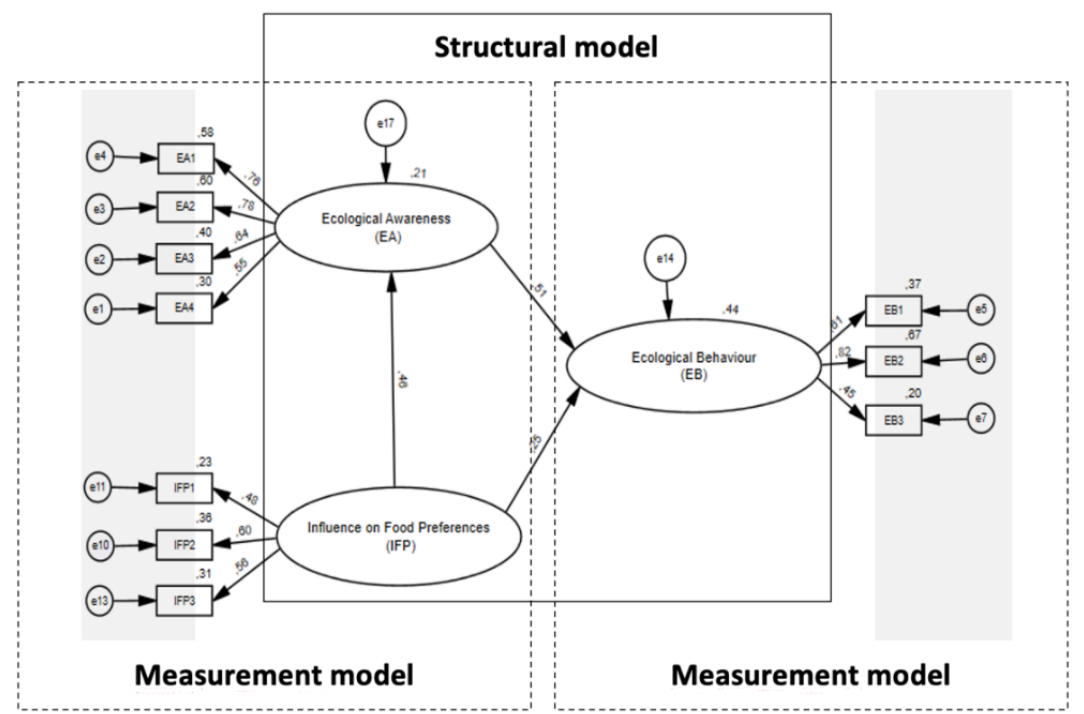
Figure 2. Structural equation model of customer ecological behavior (standardized estimates). Source: own case